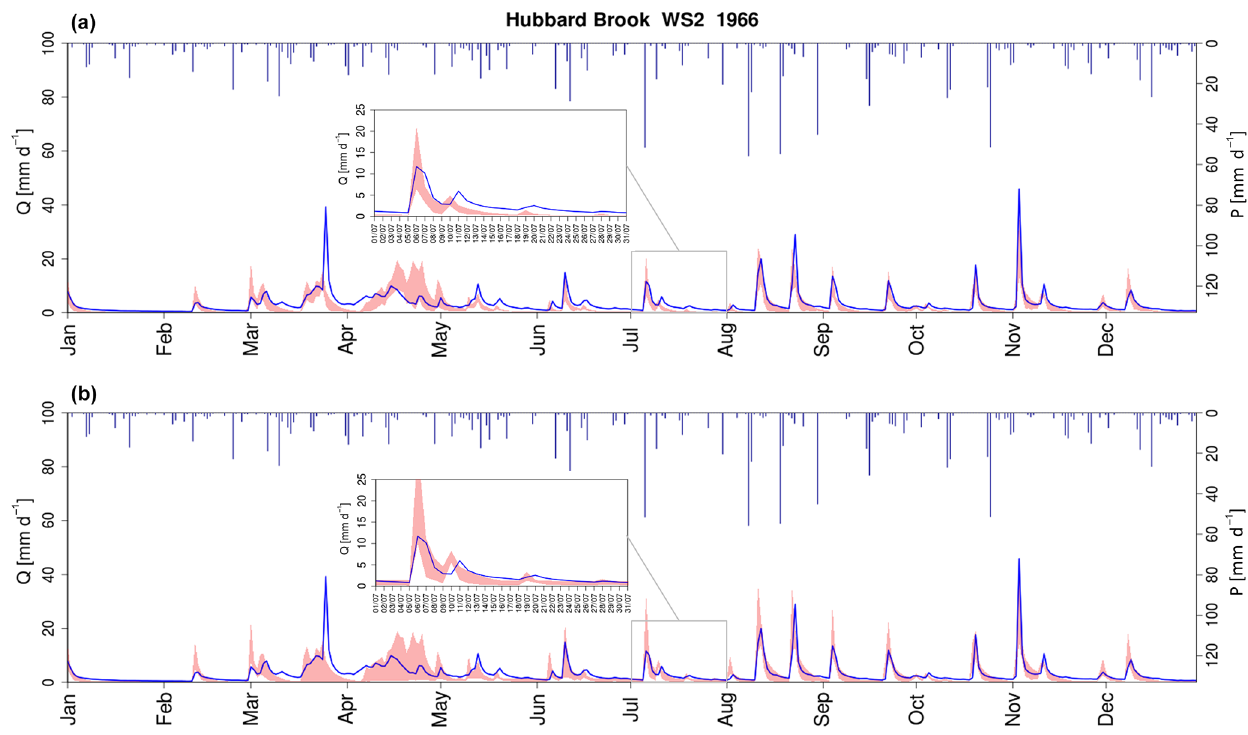
Figure 10. Hydrograph of Hubbard Brook WS2 with the observed discharge (blue) and the modelled discharge represented by the 5 / 95% uncertainty intervals (red), obtained with (a) a constant representation of the root-zone storage capacity S u, max and (b) a time-varying representation of the root-zone storage capacity S u, max . Blue bars indicate